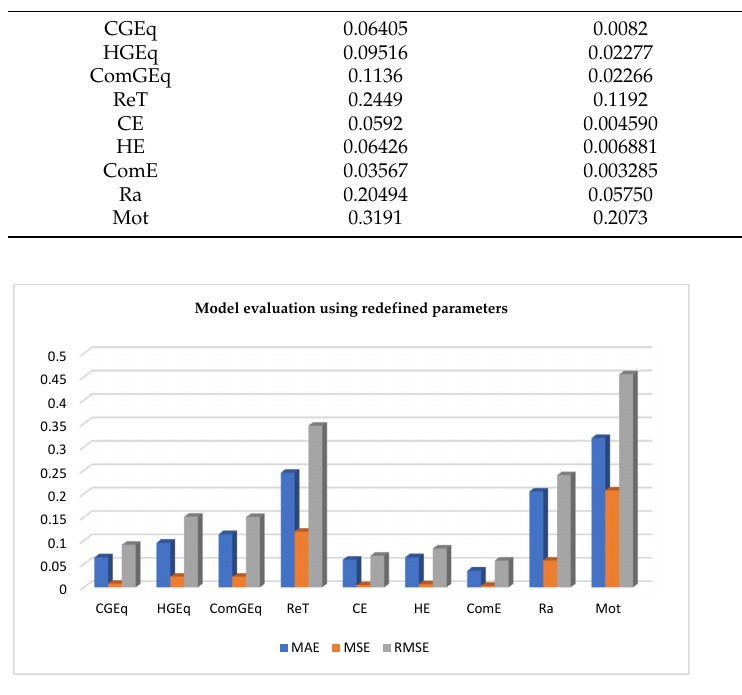
Figure 16. Model evaluation with the redefined parameters.